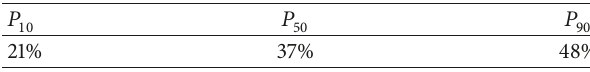
Table 4: Storage efficiency of unmineable coal seams [12]. 𝑃 10